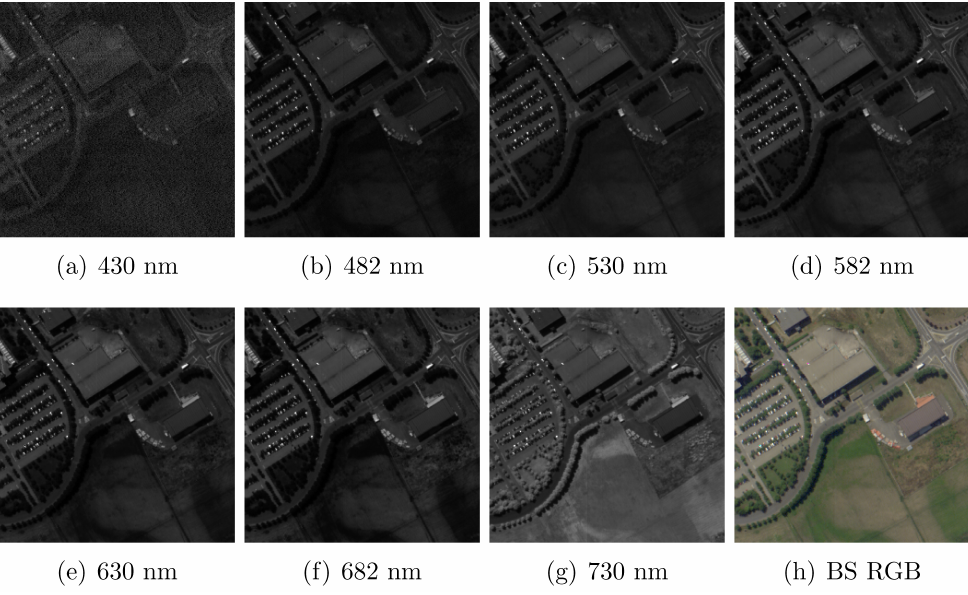
Figure 17. The seven spectral bands of the Pavia University MSI and the correponding band selection (10, 31, and 46) color RGB image for the Pavia University hyperspectral data set (right lower